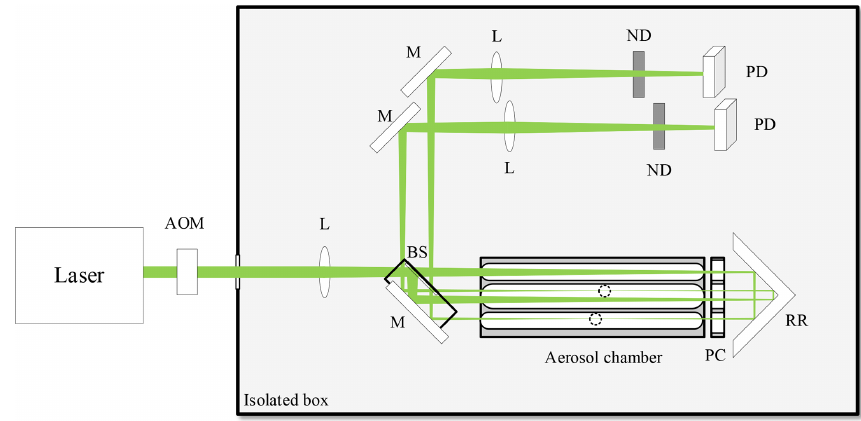
Figure 6. Schematic of the modulated single-beam photothermal interferometry (MSPTI) prototype. The label M denotes mirrors, while L, AOM, BS, PC, RR, ND and PD denote a focusing lens, acousto-optic modulator, beam splitter, pressure chamber, retroreflector, neutral density filter and photodiode, respectively. The dashed circles show the positions of the beam focus in each arm of the interferometer. An image of the experimental set-up is shown in Fig. S6 in the Supplement.